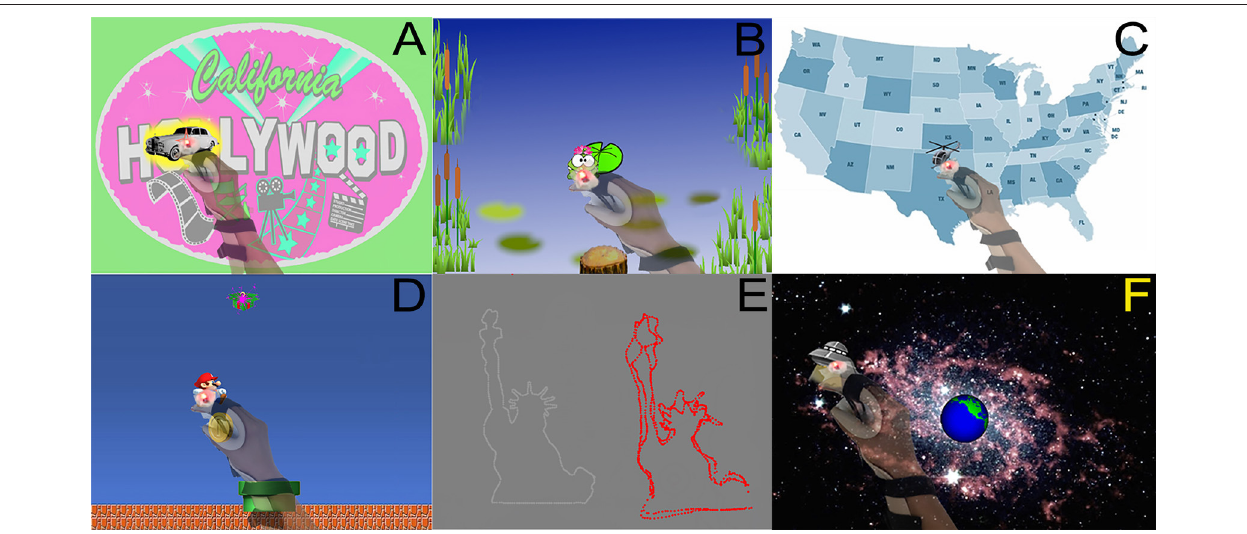
FIGURE 2 | (A) Paparazzi game, whereby subject maintained the splint’s red LED light over the white limousine. The yellow highlight around the car indicates that the subject is currently on the target. (B) Frog game, whereby a frog controlled by the subject’s movements was to be kept on a lily pad. The lily pad turned bright green when the frog was on target. (C) Map game, during which the subject kept the LED over the flying helicopter as it traveled a circuitous route across the continental USA. (D) Mario game, whereby a Mario character controlled by the splint follows a gold coin and moves toward or away from a green gift box depending on the contents of the box when they are revealed. (E) Outline game, whereby a subject used the splint LED to carefully follow a target as it outlined 1 of 20 different shapes (such as the Statue of Liberty). After each round, the actual outlined shape (in white) was presented alongside the subject’s attempts (in red). (F) UFO game, whereby the splint LED followed a UFO to prevent it from destroying the